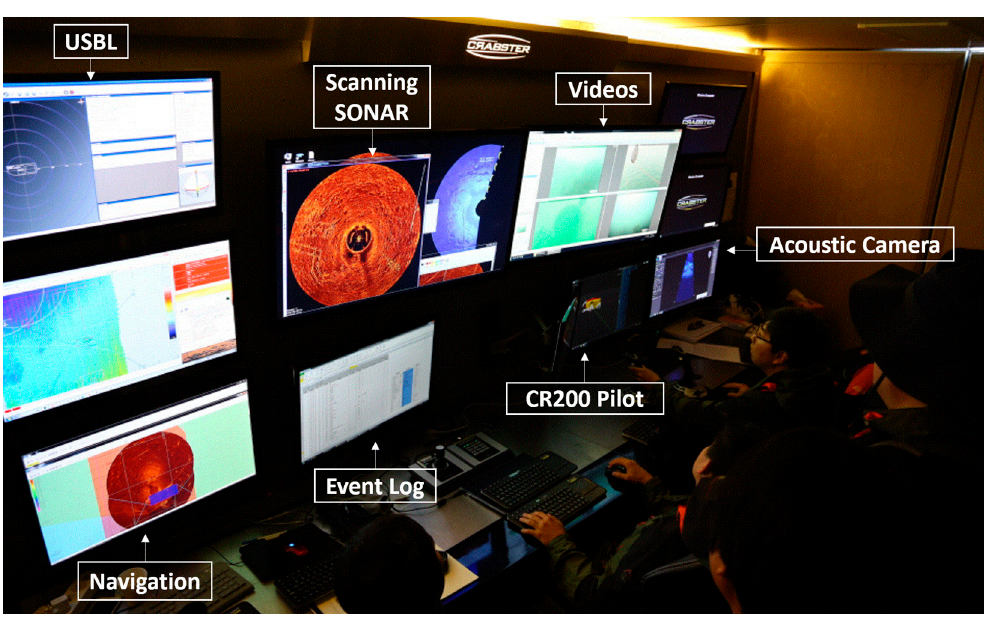
Figure 15. Inside of the control and power van.